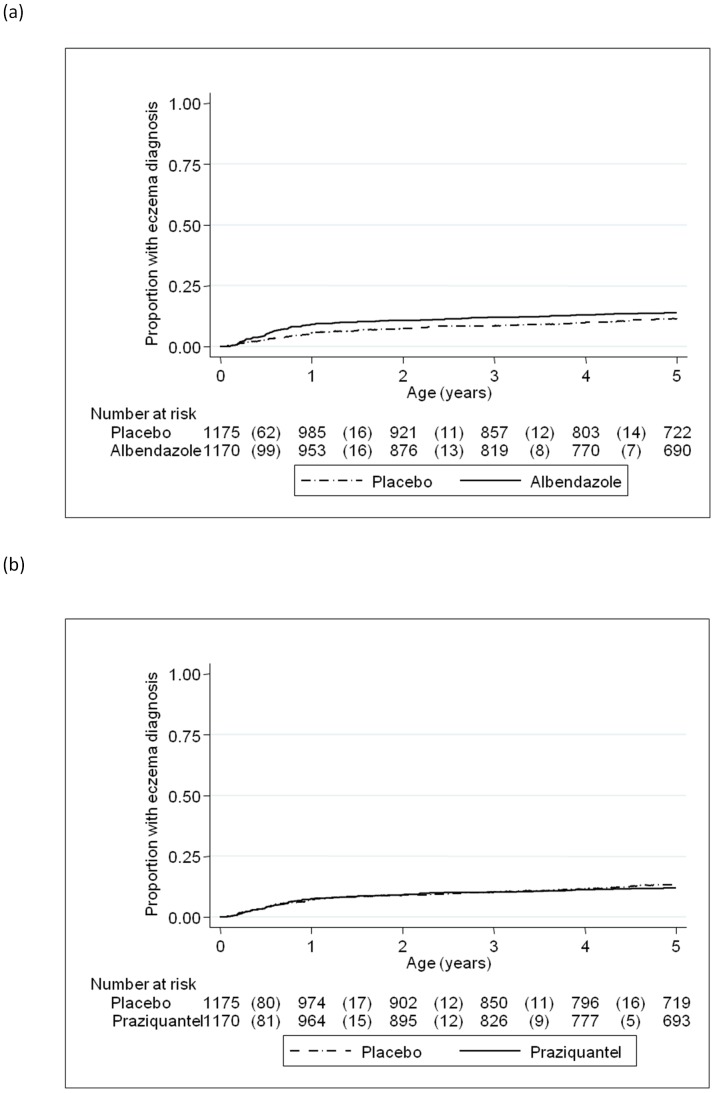
Effect of anthelminthic treatment during pregnancy on eczema incidence in the children.Kaplan-Meier survival estimates for time to first (or only episode) of eczema (a) comparing children whose mothers received albendazole during pregnancy with those whose mothers received albendazole-placebo (b) comparing children whose mothers received praziquantel during pregnancy with those whose mothers received praziquantel-placebo. Numbers shown in the tables are number of events (in brackets) and number of children at risk.